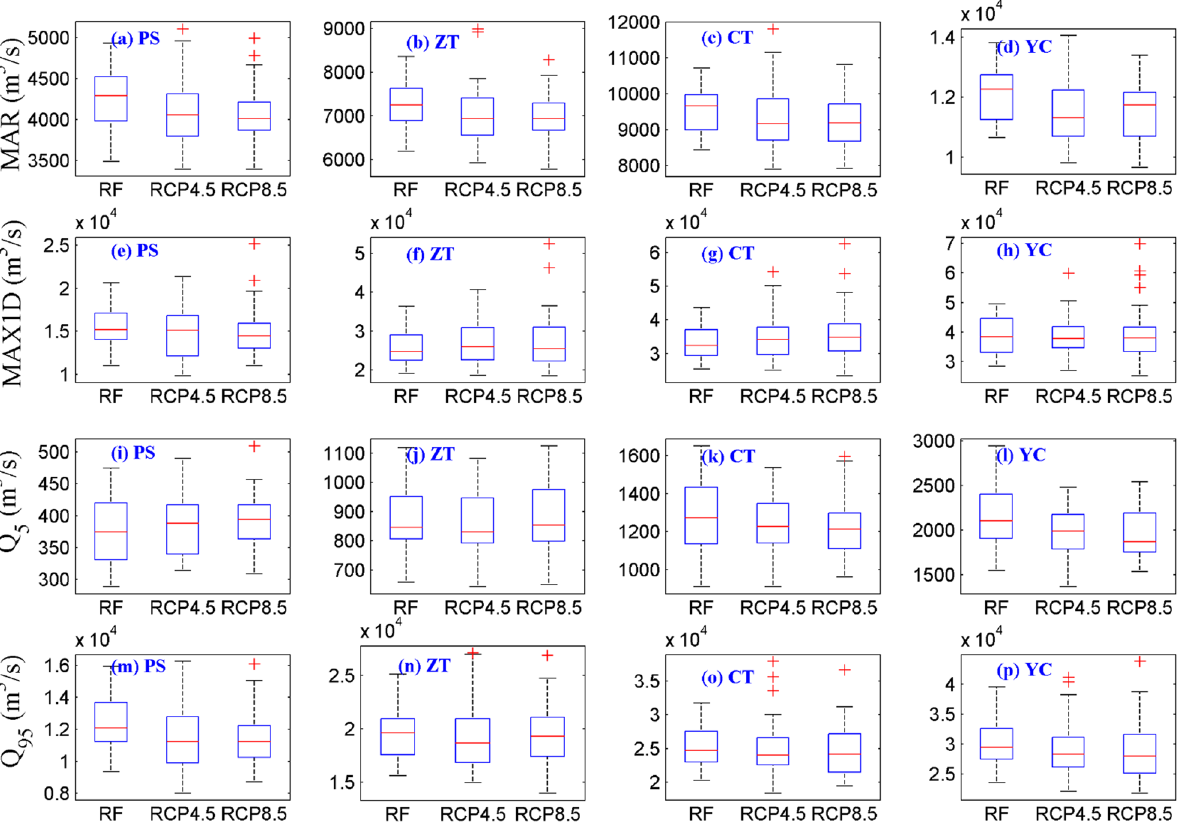
Figure 12. Box plots of the MAR (a–d) , MAX1D (e–h) , Q 5 (i–l) and Q 95 (m–p) for the PS, ZT, CT and YC stations for the reference period (RF) and future period (RCP4.5 and RCP8.5). The figure was generated by MATLAB2019a (https:// www. mathw orks.